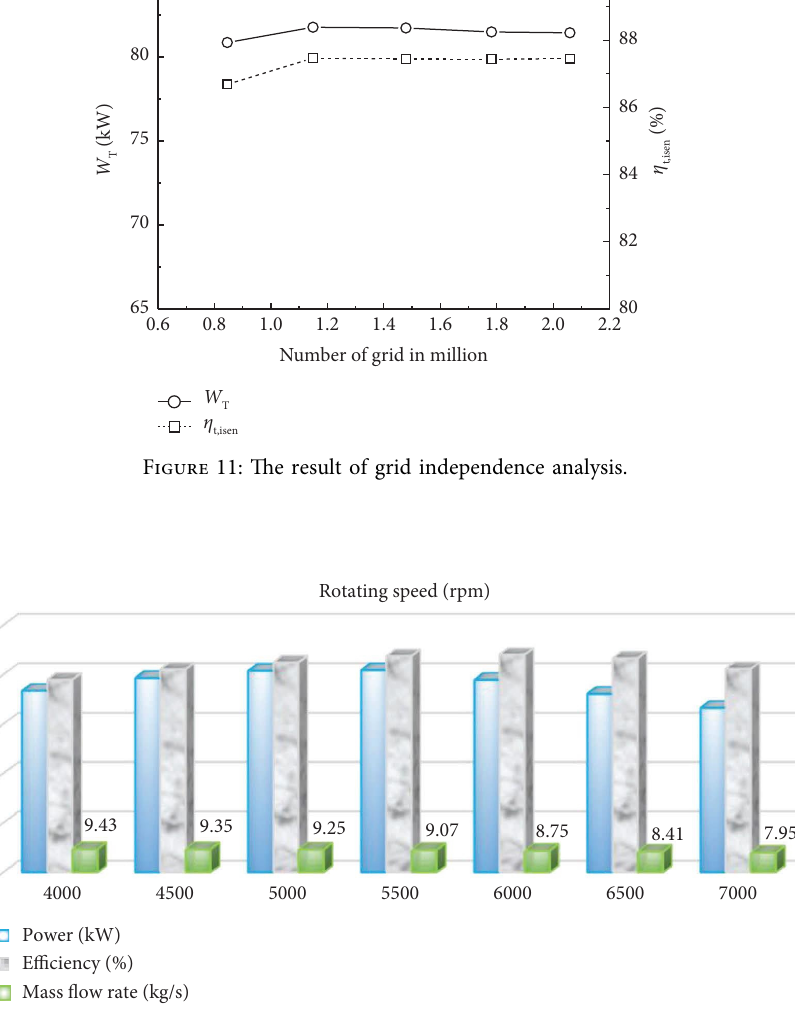
Figure 12: Te infuence of rotational speed of impeller.